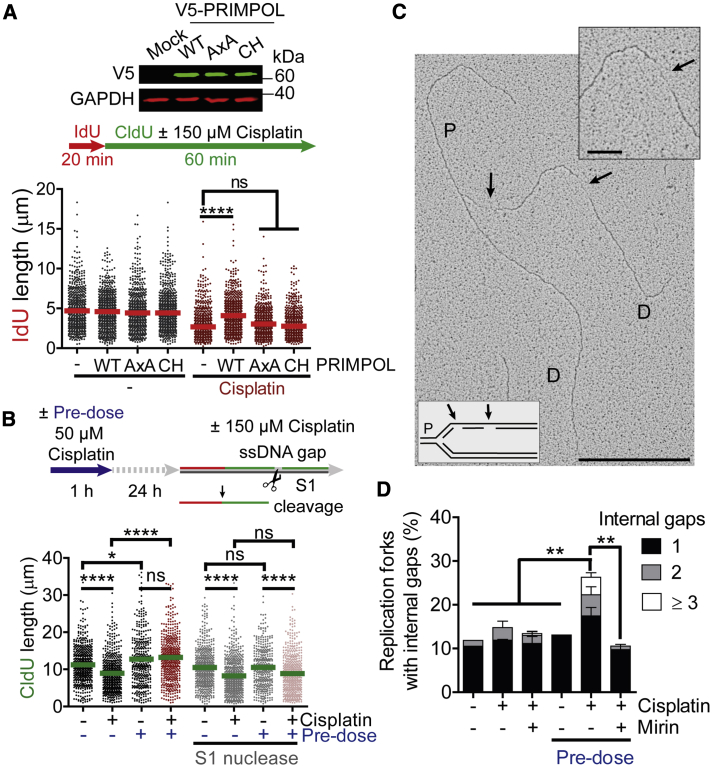
PRIMPOL Primase Activity Rescues Nascent Strand Degradation in BRCA1-Deficient Cells(A) PRIMPOL overexpression in UW cells upon transfection with WT (wild-type), AxA (catalytic dead) and CH (primase dead only) V5-PRIMPOL constructs (top). Dot plot and median of IdU tract lengths in UW cells overexpressing the different constructs ± 150 μM cisplatin (bottom) (n = 3). ns, non-significant, ∗∗∗∗p < 0.0001.(B) Schematic for detection of ssDNA gaps using the ssDNA-specific S1 nuclease upon multiple treatments with cisplatin (top). Dot plot and median of CldU tract lengths in UW cells ± 150 μM cisplatin ± pre-dose ± S1 nuclease (bottom) (n = 3). ns, non-significant, ∗p < 0.05, ∗∗∗∗p < 0.0001.(C) Representative electron micrograph of a replication fork with internal ssDNA gaps behind the fork indicated by the arrows. Scale bar: 500 nm (left). Magnified internal ssDNA gap. Scale bar: 100 nm (right). P: parental strand, D: daughter strand.(D) Percentage of replication forks with 1, 2 or ≥3 internal ssDNA gaps in UW cells ± 150 μM cisplatin ± pre-dose ± mirin. Means ± SEM (n = 3). Statistics: one-way ANOVA followed by Bonferroni test. ∗∗p < 0.01.See also Figure S4 and Table S1.